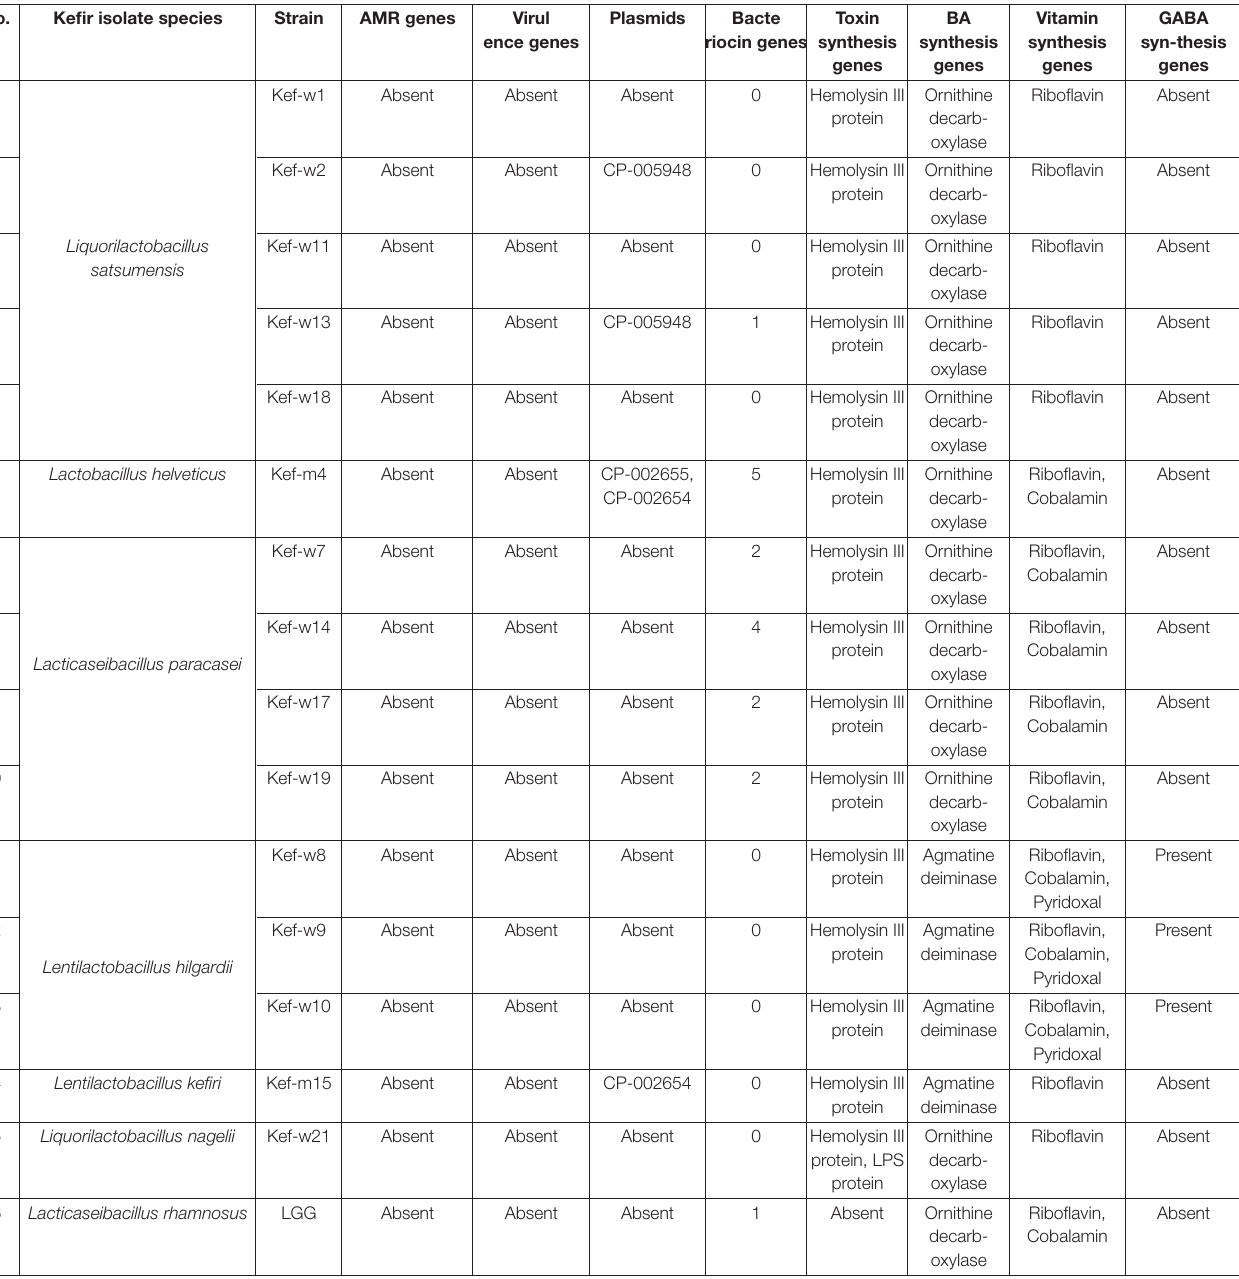
TABLE 6 | Genetic features of selected kefir